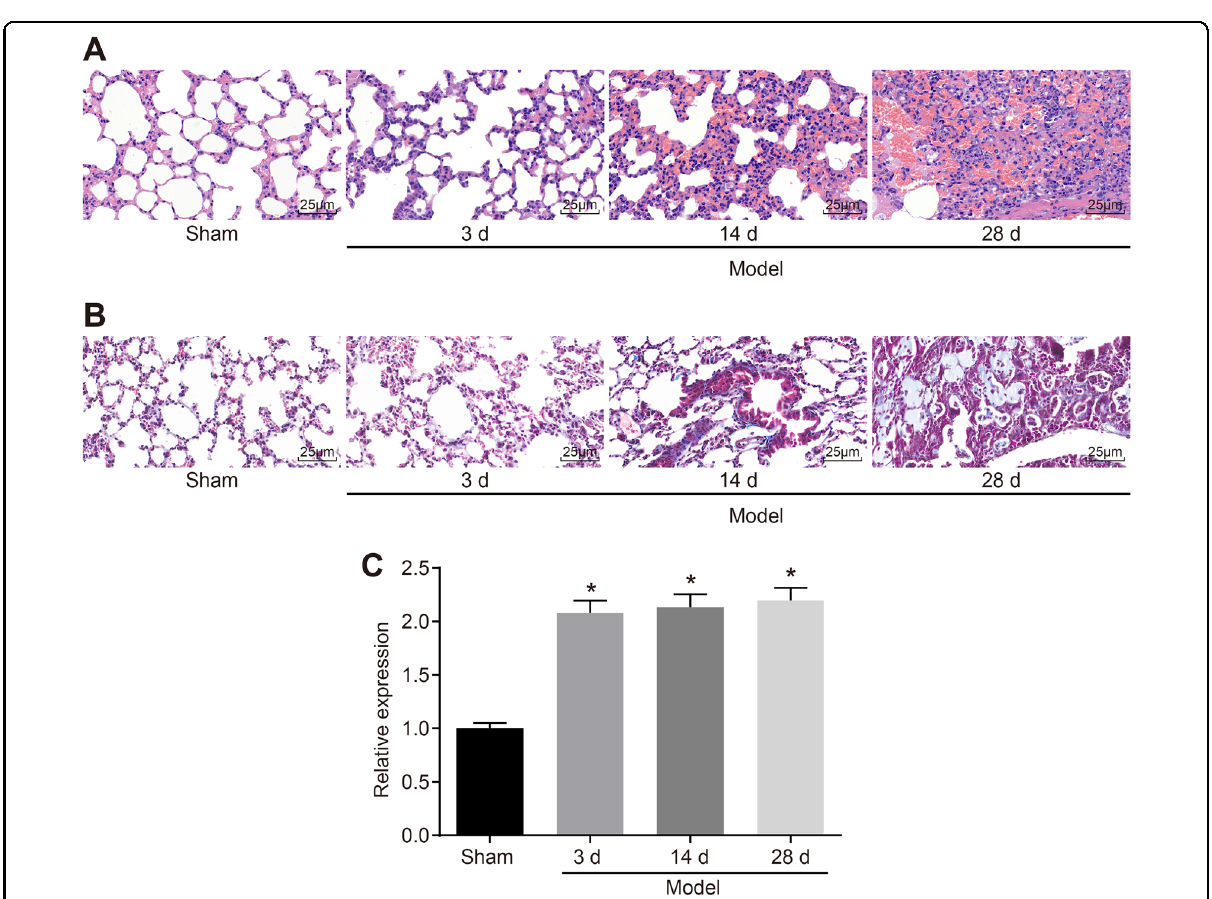
Fig. 2 miR-328 expression is upregulated in PF . a HE staining of lung tissue 3 d, 14 d and 28 d after modeling (400 × ). b Masson staining of lung tissue 3 d, 14 d and 28 d after modeling (400× ). c , miR-328 levels 3 d, 14 d and 28 d after modeling examined by RT-qPCR . * p < 0.05 vs . the sham group; miR-328, microRNA-328; HE, hematoxylin-eosin; RT-qPCR , reverse transcription quantitative polymerase chain reaction; and PF, pulmonary fi brosis. All results were measurement data and were analyzed using one-way analysis of variance. The results are expressed as the mean ± standard deviation; the sham group, n = 18; and the PF group, n =